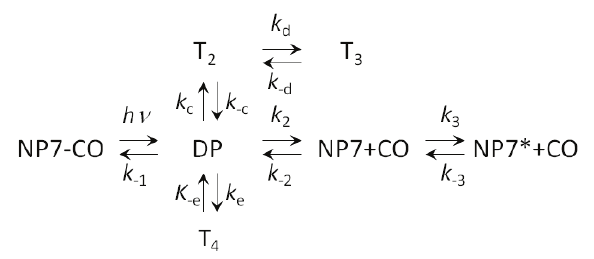
Figure 11. Minimal reaction scheme for the observed rebinding kinetics. Reaction intermediates T inside the protein.